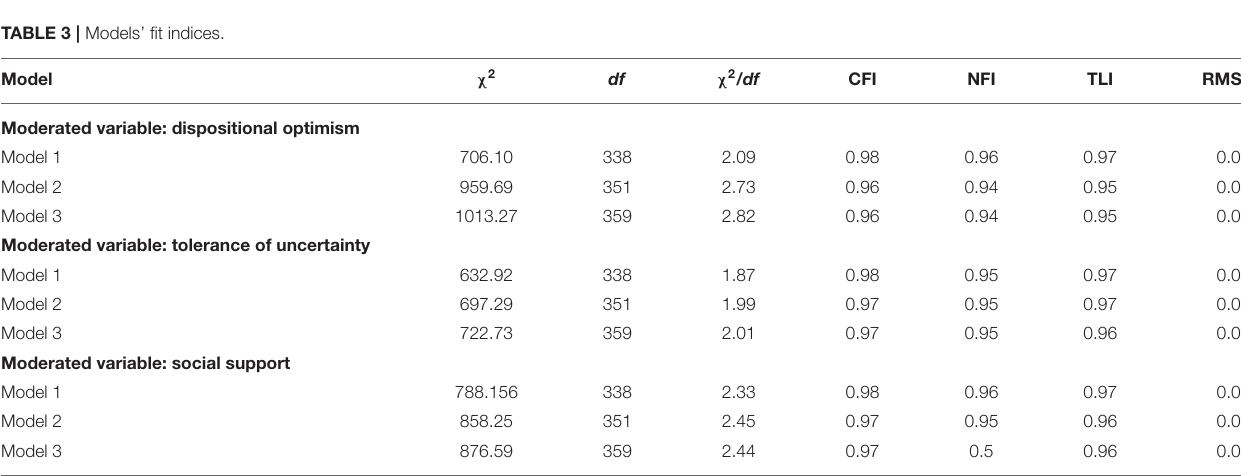
TABLE 3 | Models’ fit